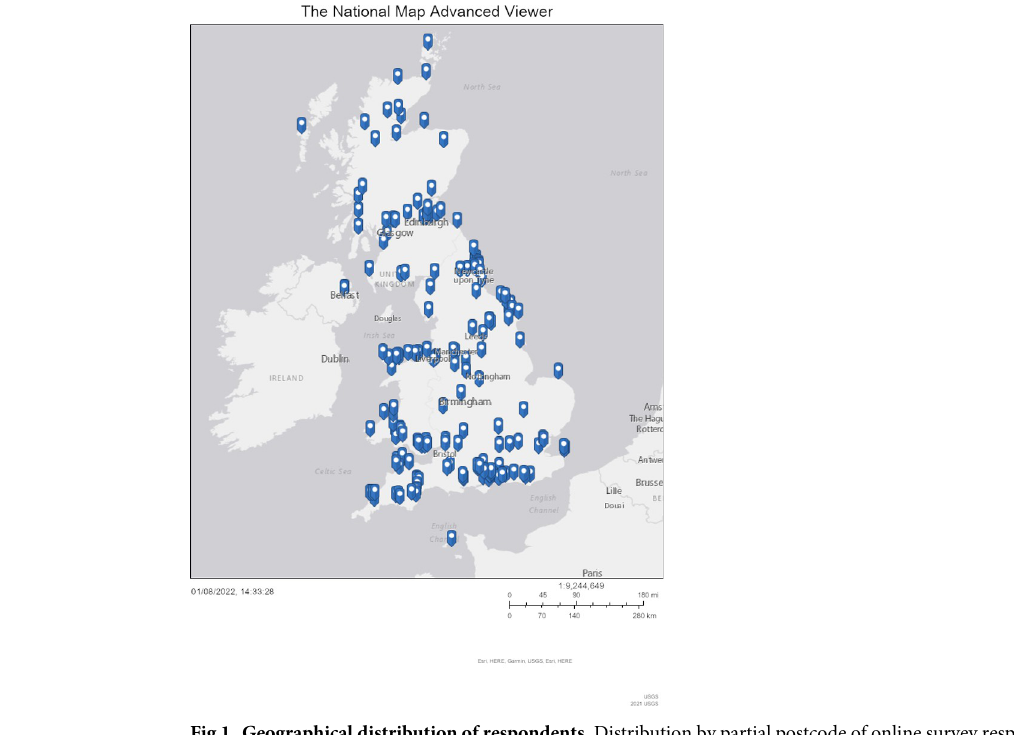
Fig 1. Geographical distribution of respondents. Distribution by partial postcode of online survey respondents from three case studies: a town-based marine group (n = 22), a regional marine group (n = 30), and a national marine citizen science project (n = 228). Markers indicate one or more respondents at each postcode location. Map constructed in USGS National Map Viewer.